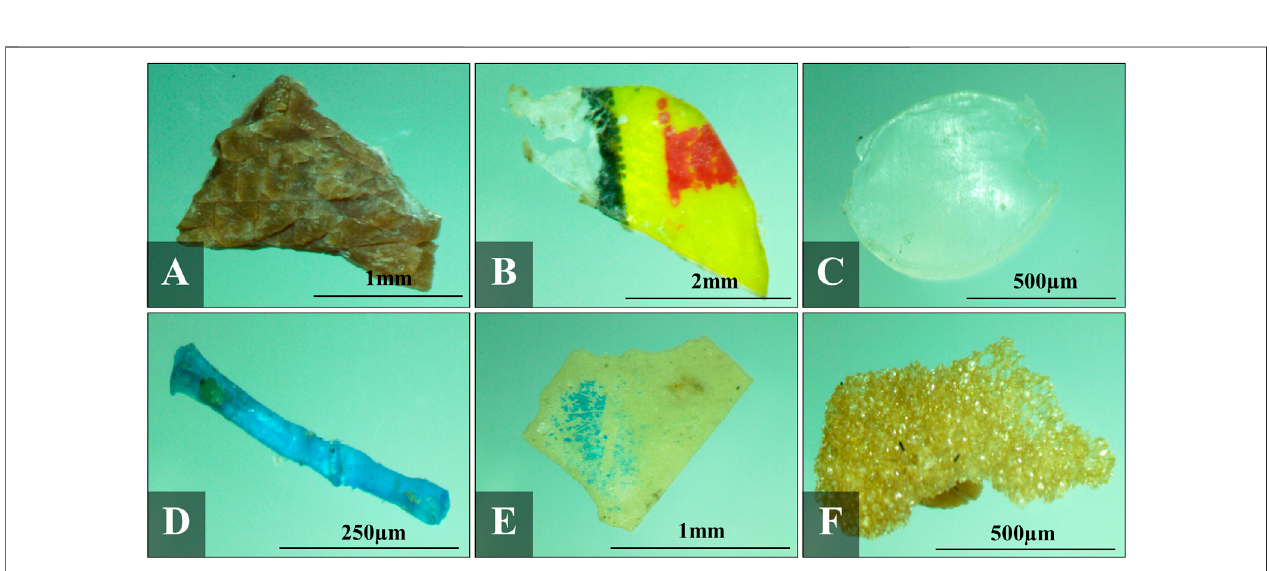
FIGURE 4 | Photographs of different shapes of microplastics collected in all samples: (A) fragment, (B) fi lm, (C) pellet, (D) line, (E) sheet, and (F) foam.